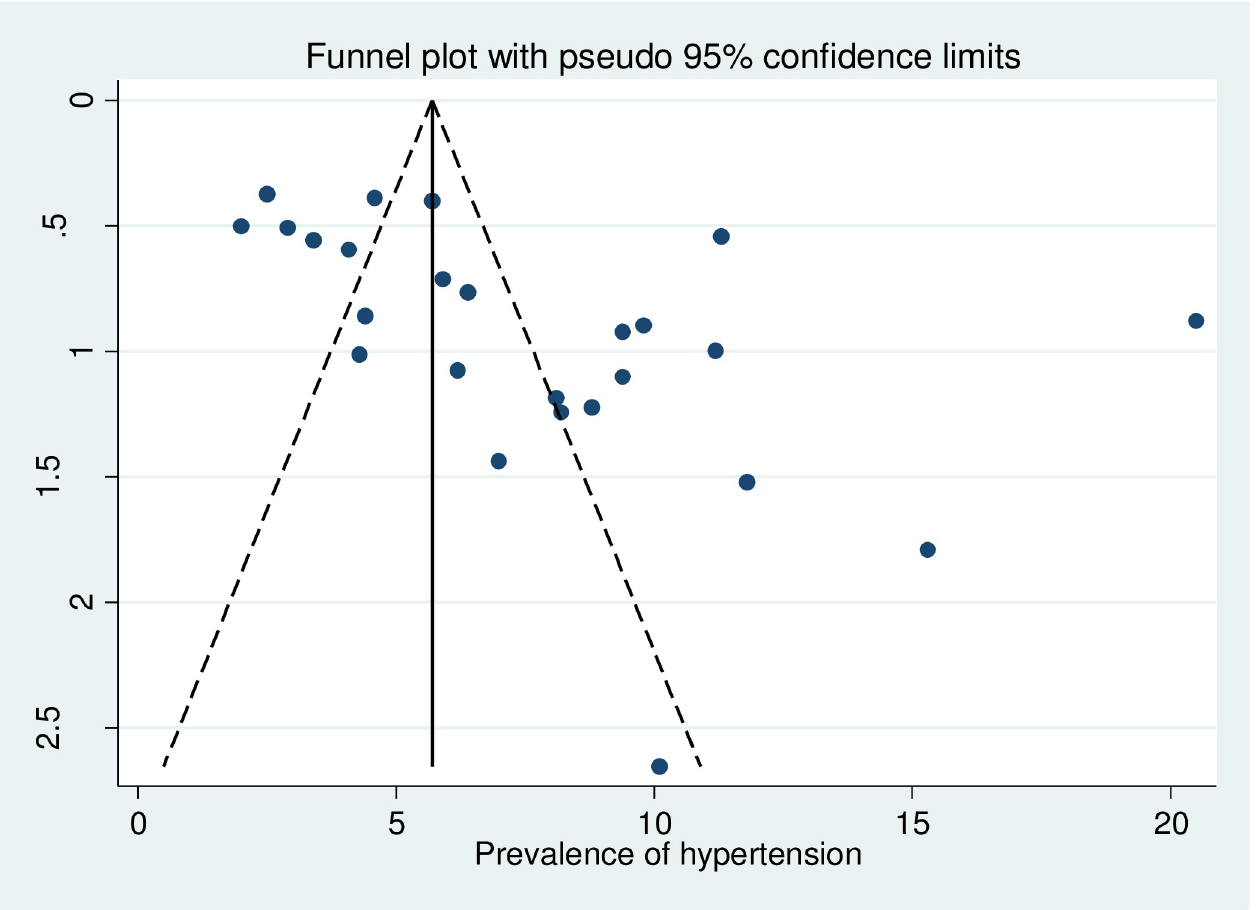
Fig 6. Funnel plot to check for publication bias.